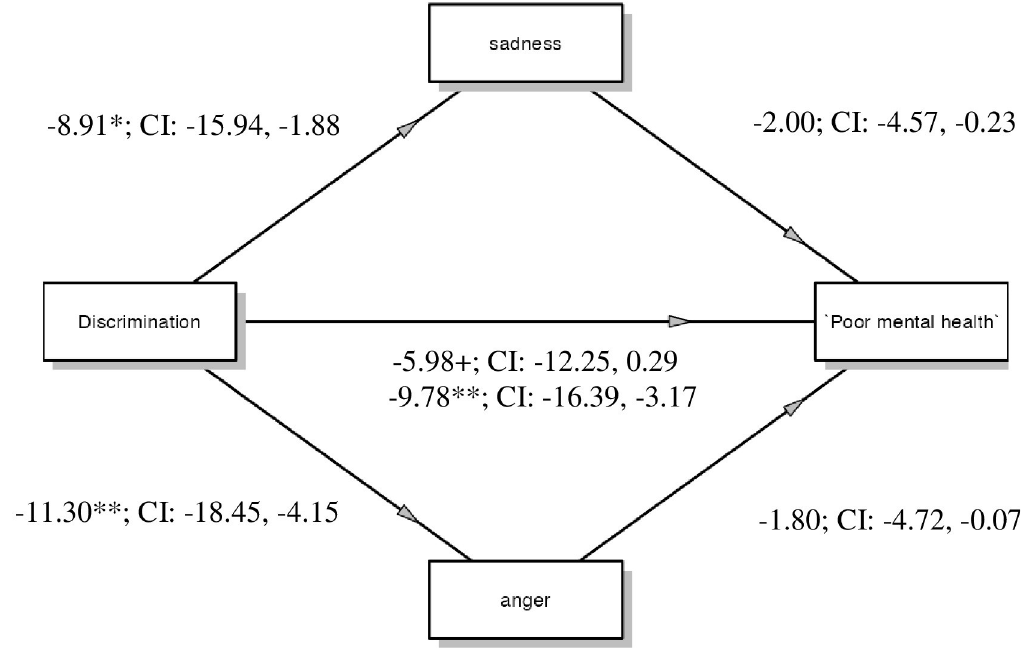
Fig 3. Multiple mediation model: Anger and sadness mediate the relationship between covid-19 based discrimination and poor mental health. Note : �� p < 0.01, � p < 0.05, � p < 0.10.